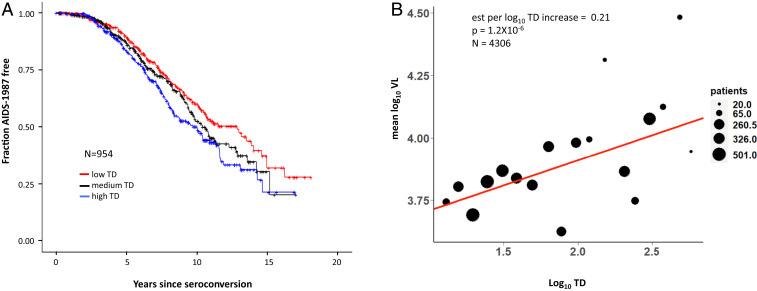
Tapasin dependence impacts HIV-1 disease. (A) Kaplan–Meyer curves for time to AIDS-1987 are shown for a cohort of ART-naïve HIV-1 seroconverters equally divided based on their global TD (high, medium, and low, n = 318 in each group). (B) Mean log10VL plotted against log10TD level is shown for a cohort of ART-naïve HIV-1 patients. Each dot represents the mean log10VL of patient groups divided into increasing bins of 0.1 log10TD. Estimate (est), and P value were derived by regression analysis adjusted by race.